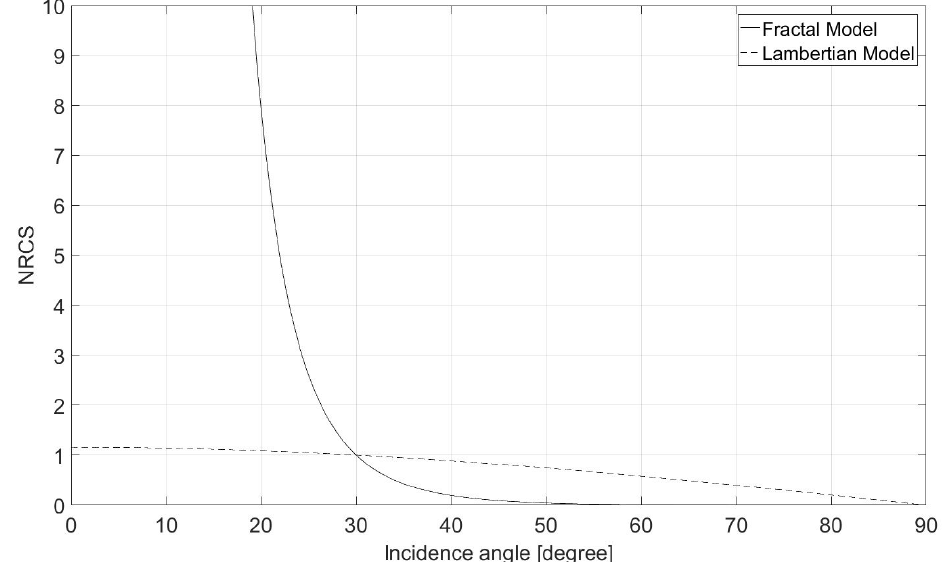
Figure 1. Comparison between the proposed fractal scattering model (continuous line) and the Lambertian law (dashed line) as functions of the incidence angle. The radar-look angle is set to 30 ◦ . The models are calibrated in order to be both equal to one for a flat surface. Both the scattering models go to zero under grazing incidence conditions; the fractal scattering model is not